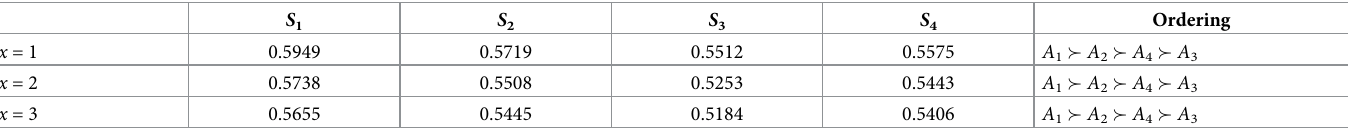
Table 3. Ranking results for different parameter.